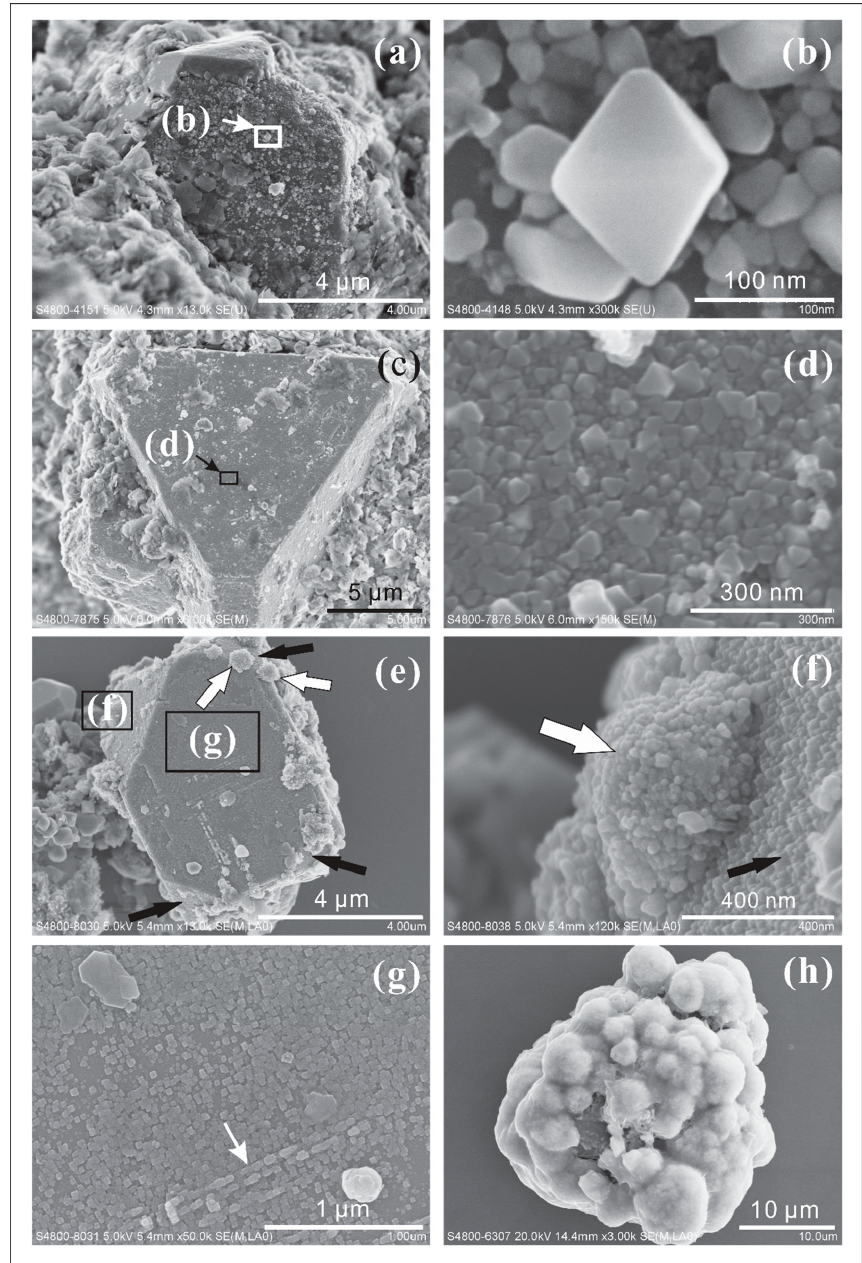
Figure 8. SEM images of pyrite aggregates. ( b ) showed octahedral pyrite crystals highlighted in ( a ). ( d ) An aggregate of octahedral pyrite crystals on the surface of one bigger crystal in ( c ). ( f , h ) Irregular pyrite nanocrystals aggregate as spherulites. ( g ) The linear arrangement of pyrite nanocrystals on the surface of a big pyrite crystal ( e ). V: Irregular pyrite nanocrystals aggregate as spherulites (Figure 8e,f,h). Some of the small single aggregates (~500 nm) attach to the surfaces of large pyrite crystals (white arrows in Figure 8e,f). Some